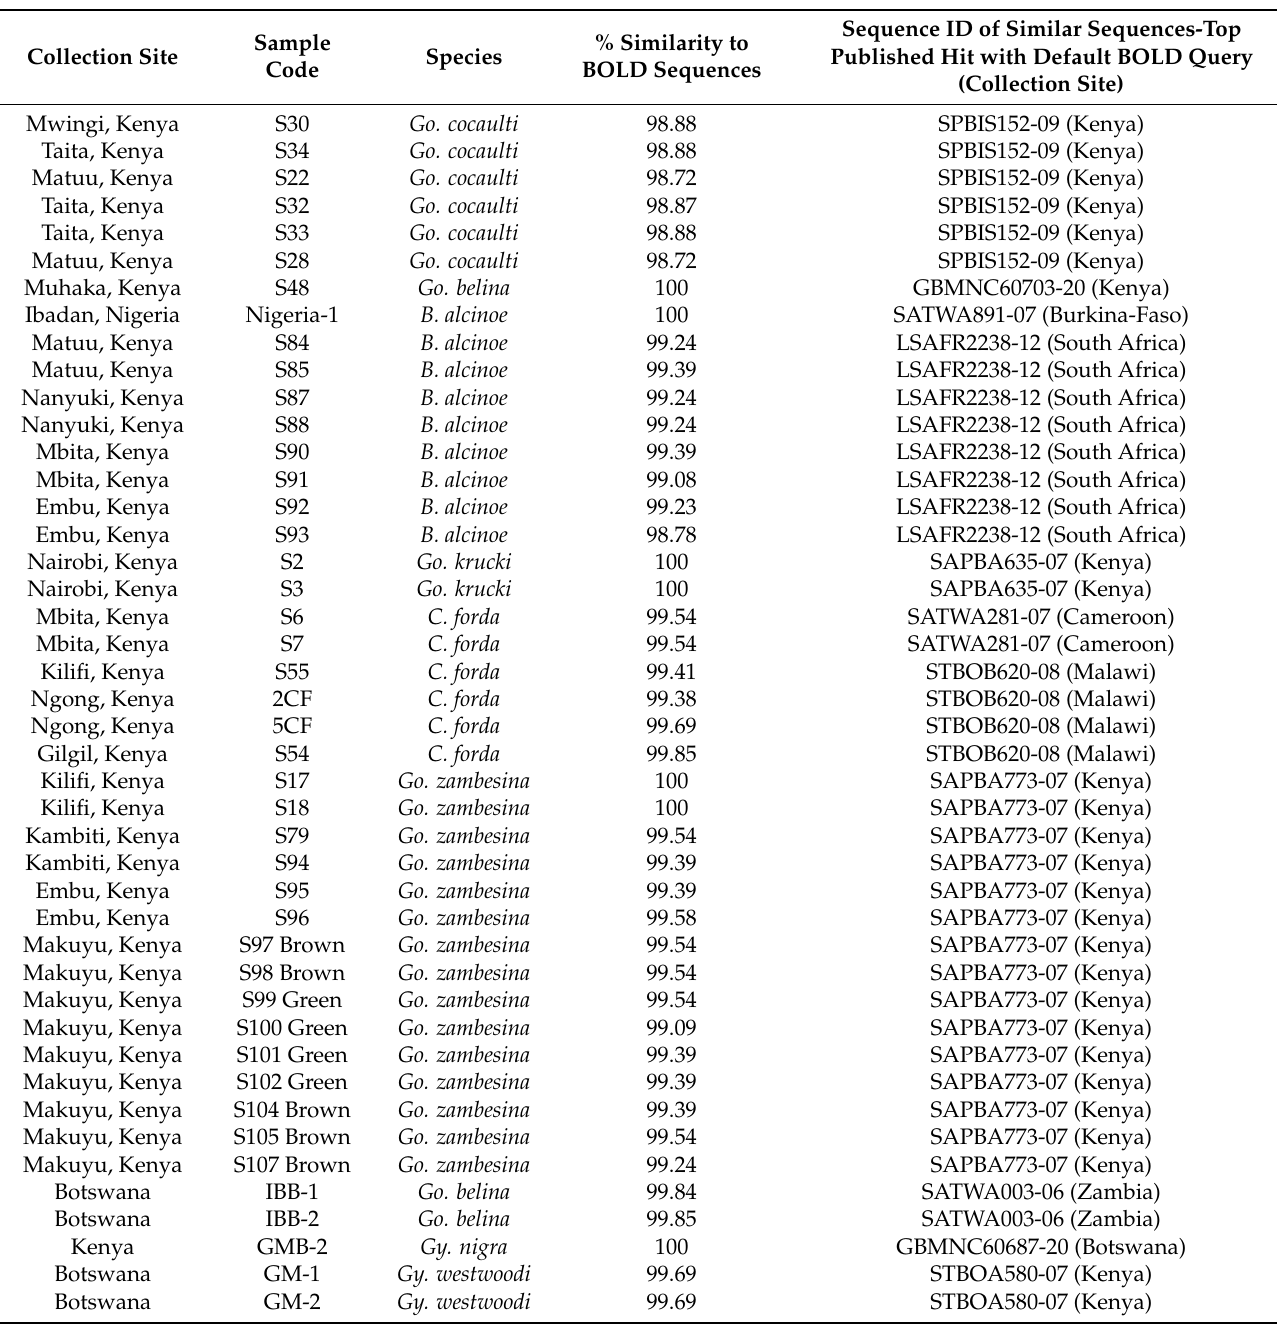
Table 2. Identities of saturniids based on similarities with sequences from